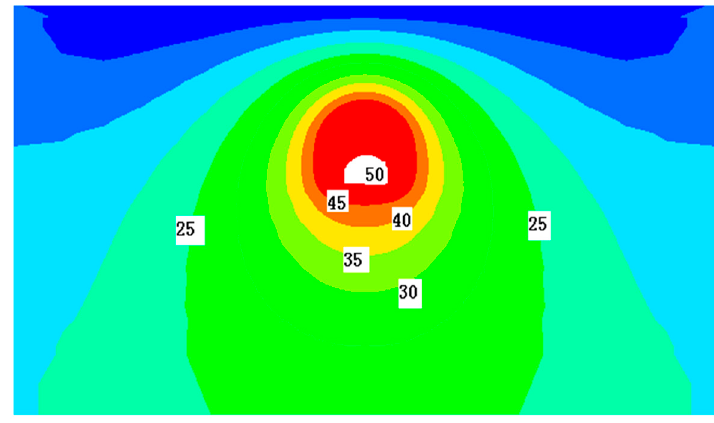
Figure 10. Temperature field distribution of the main tunnel (Units: °C).